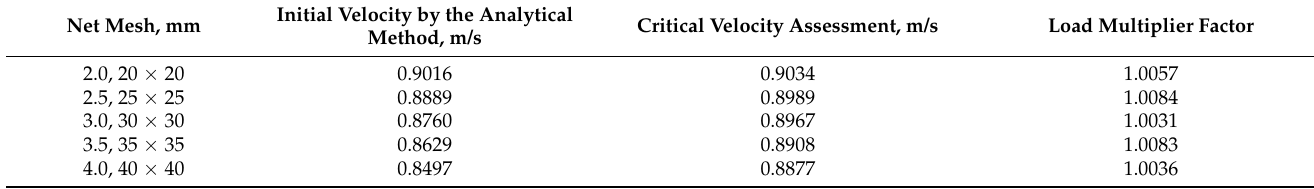
Table 4. The effect of net mesh and yarn diameter on the critical velocity, for the Drift State.